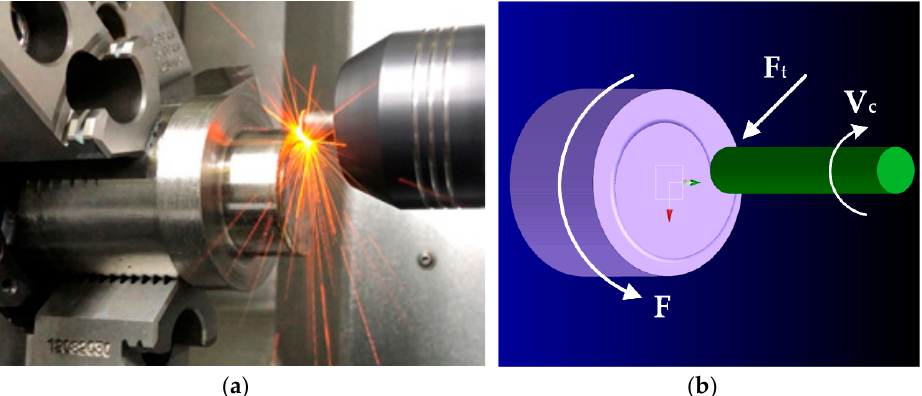
Figure 7. Strategy for resistance testing of solid ceramic end mills: ( a ) general view of the ceramic end mill location relative to the NiCr20TiAl nickel alloy workpiece during testing; and ( b ) processing strategy visualization.